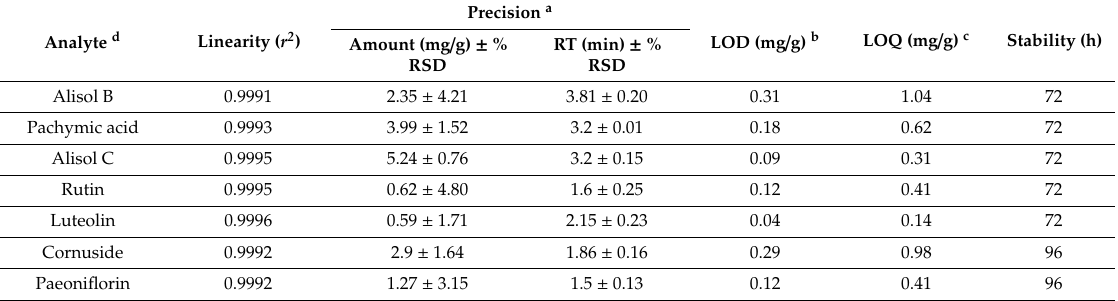
Table 8. The precision of